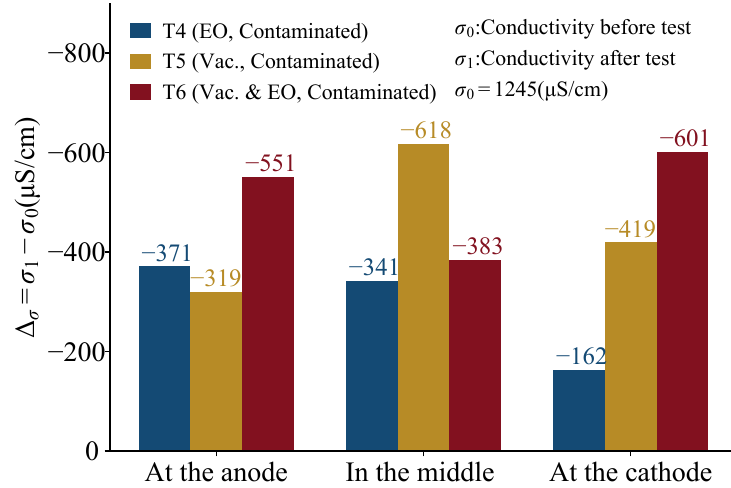
Figure 13. Conductivity difference of the contaminated